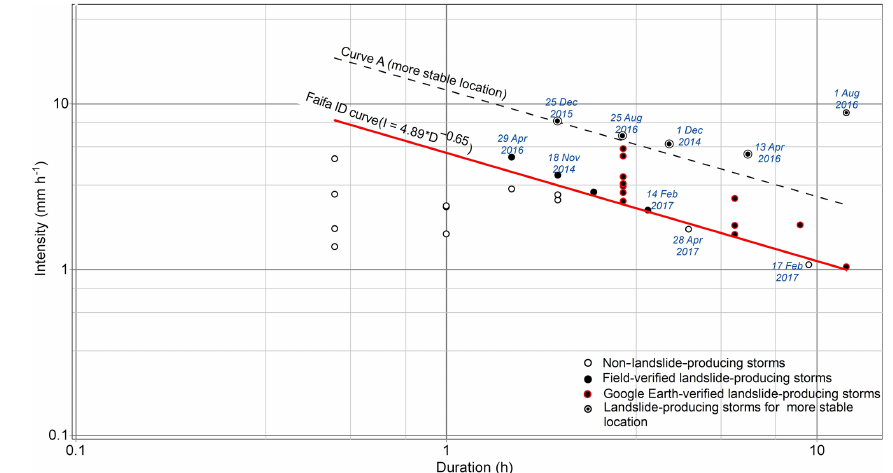
Figure 8. Demonstration of pixel-based ID curves. Curve A is a curve for a more stable pixel that witnessed landslides in response to five storms (1 December 2014, 25 December 2015, 13 April 2016, 1 and 25 August 2016). The ID curve for the more stable location is parallel to the Faifa ID curve that separates landslide-producing storm events from non-landslide-producing storm events from Fig. 4.